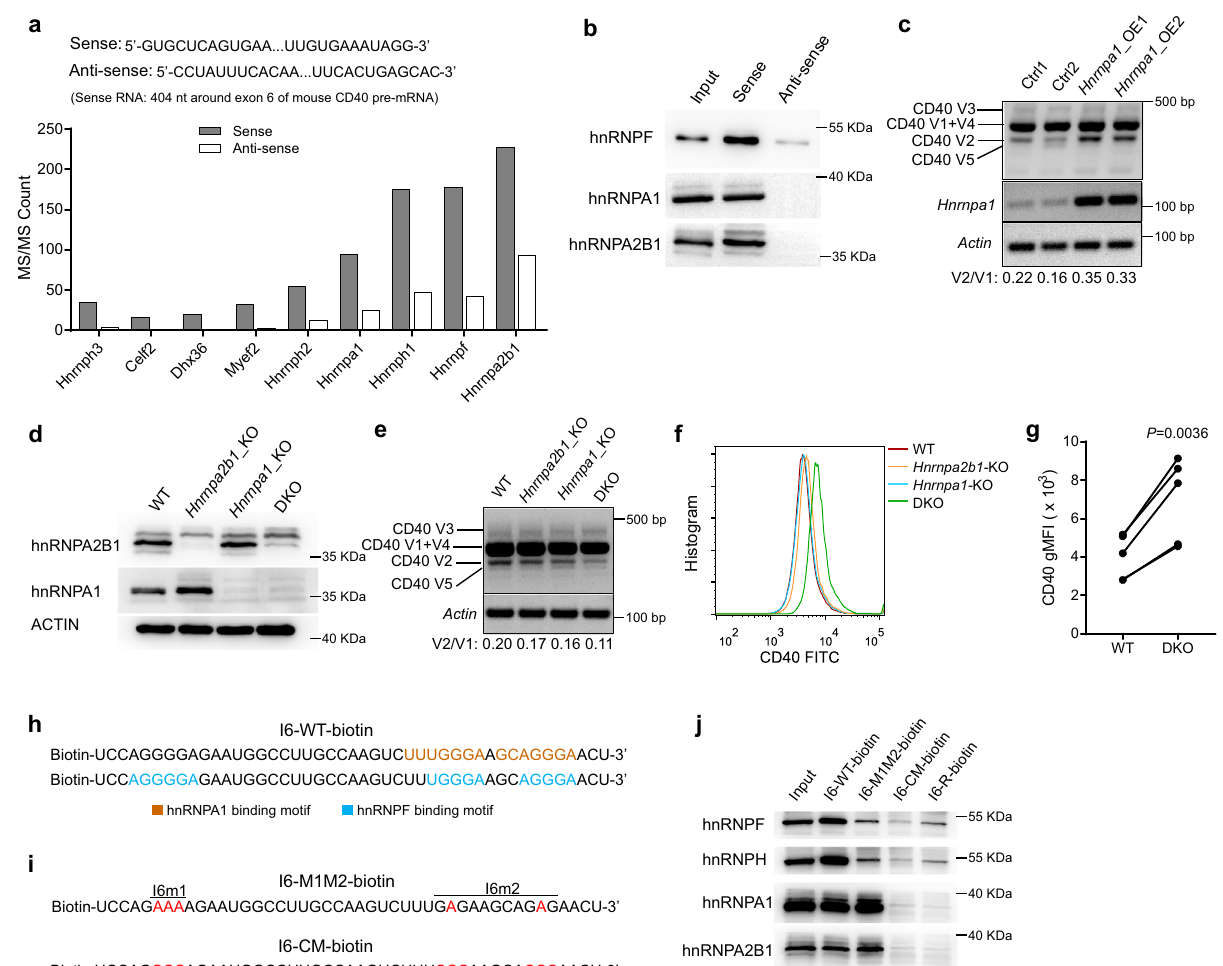
Fig.8|hnRNPA1andA2B1binddirectlyto Cd40 pre-mRNAandregulateitsAS. a Cd40 pre-mRNA-bindingproteinspulleddownbythesequencecorrespondingits exon 6 and the fl anking intronic regions. The pulled-down proteins were analyzed by mass spectrometry. Top proteins with a fold change of LFQ intensity of more than5andMS/MScountwithsenseRNAofmorethan15wereshown.Dataarefrom one singleexperiment. b Immunoblotting of hnRNP F,A1,and A2B1proteinsinthe pull-down lysates using biotinylated sense and antisense RNAs as shown in a . Data are representative from two independent experiments. c RT-PCR analysis of Cd40 variants using primers P1 and P2 in B cells retrovirally transduced with control or hnRNP A1-overexpressing vectors. d Immunoblotting of hnRNP A1 or A2B1 in the splenicBcellsfromtheWTanddifferentknockoutmice. e RT-PCRanalysisof Cd40